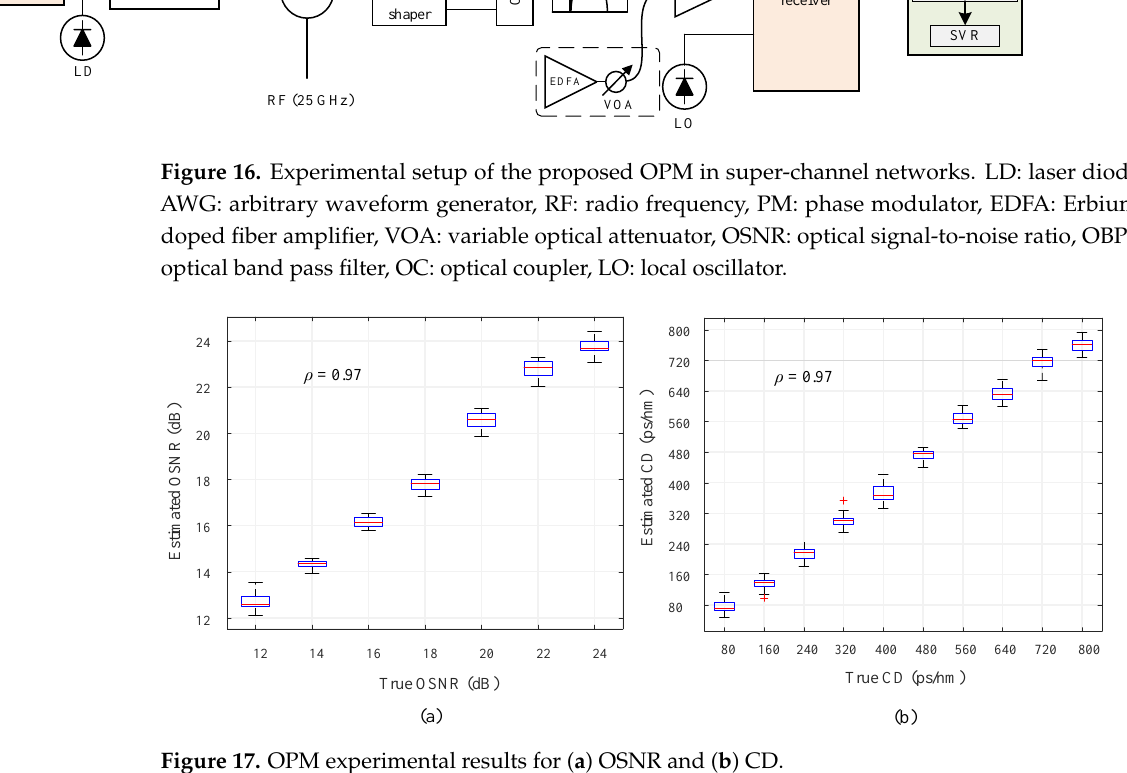
Figure 17. OPM experimental results for ( a ) OSNR and ( b ) CD.